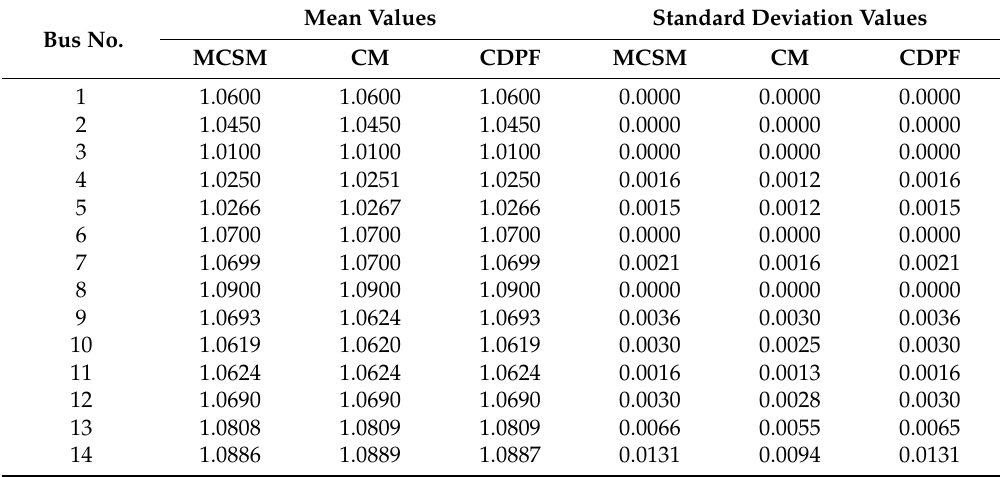
Table 2. The means and standard deviations of the active power (p.u.) at the branches in an IEEE 14-bus power system.